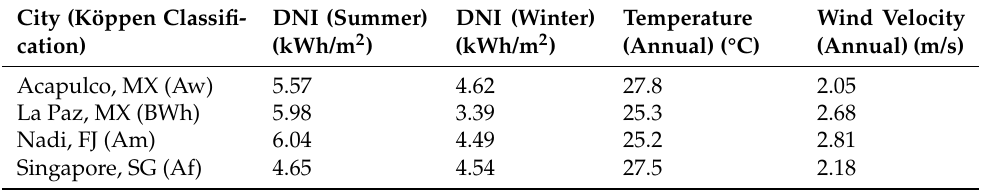
Table 4. Average daily weather conditions of selected